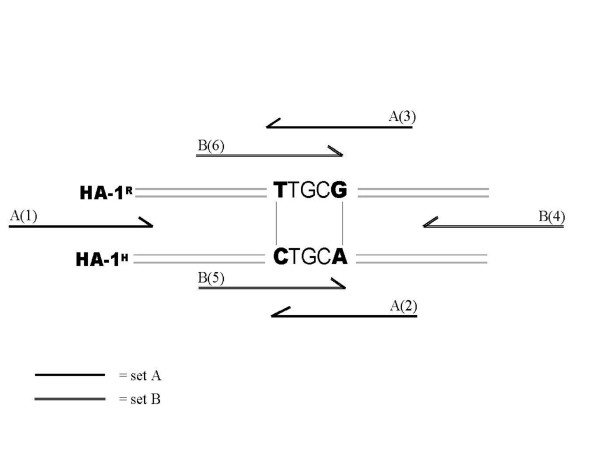
Relative positions of primer pair sets A and B designed to perform allele-specific PCR typing at the HA-1 locus. A(1) is the forward primer common to site-specific primers A(2) and A(3) designed with the 3'OH-end at c.500C/T. B(4) is the reverse primer common to site-specific primers B(5) and B(6) designed with the 3'OH-end at c.504A/G. Primer combinations A(1) + A(2) and B(4) + B(5) are specific for HA-1H. Primer combinations A(1) + A(3) and B(4) + B(6) are specific for HA-1R.